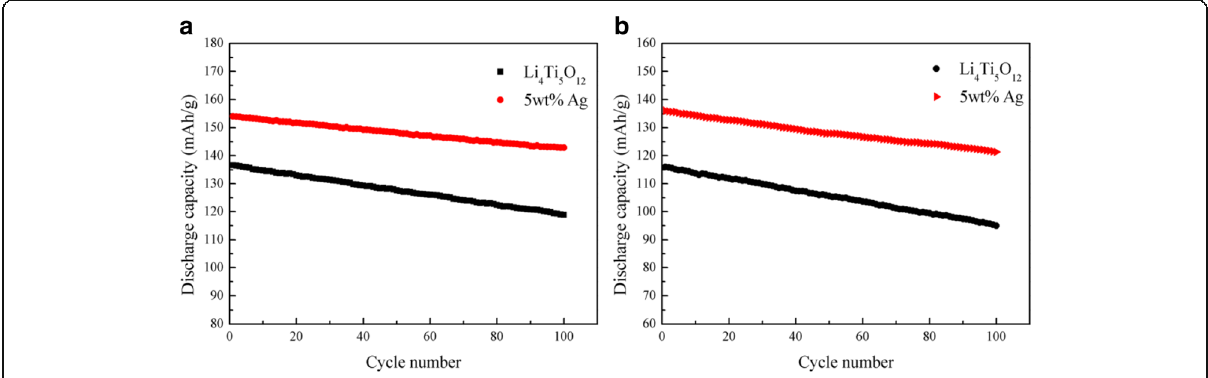
Fig. 6 The cycling performance of the Ag-free and the 5 wt.% Ag-coated Li 4 Ti 5 O 12 at 5 °C ( a ) and 10 °C ( b